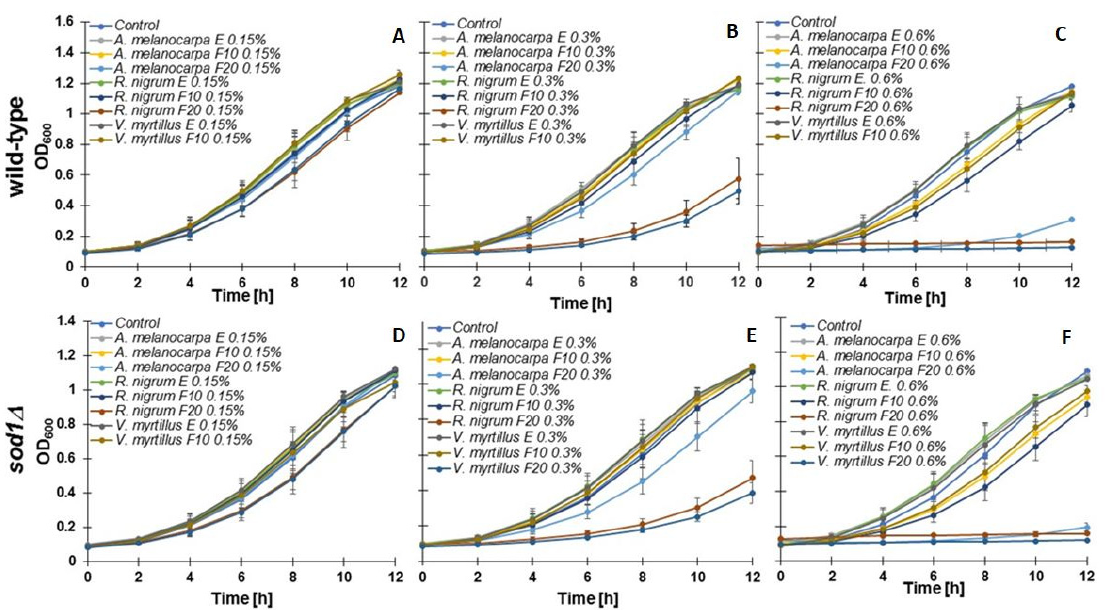
Figure 3. Growth kinetics of the wild-type yeast BY4741 ( A – C ) and the isogenic mutant sod1 Δ ( D – F ) treated with extracts and ferments (F10 and F20) of R. nigrum , A. melanocarpa , and V. myrtillus . The optical density (OD 600 ) of the culture was measured for 12 h at different points. The data presented are replicates from two independent cultures ± SD, which are smaller or equal in size to the symbol size.